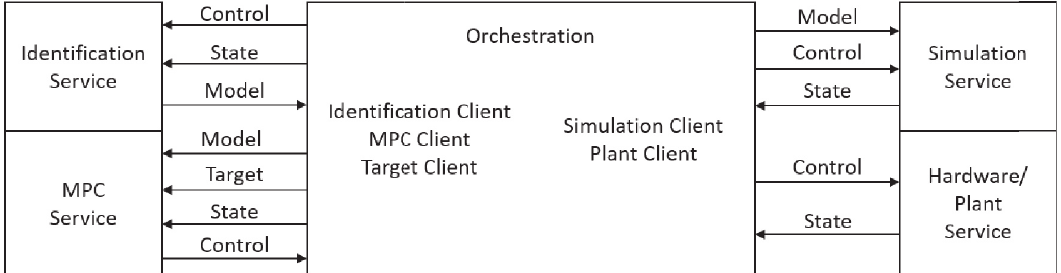
Fig. 1. System architeecture for service-based identification and control.